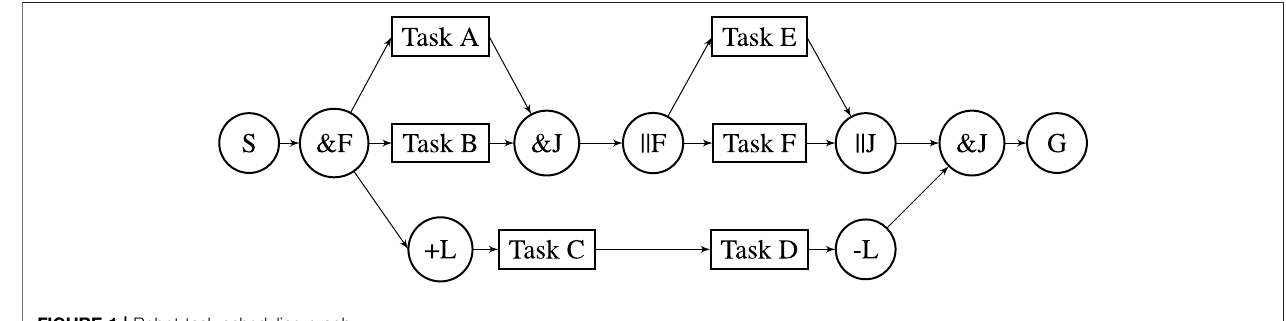
FIGURE 1 | Robot task scheduling